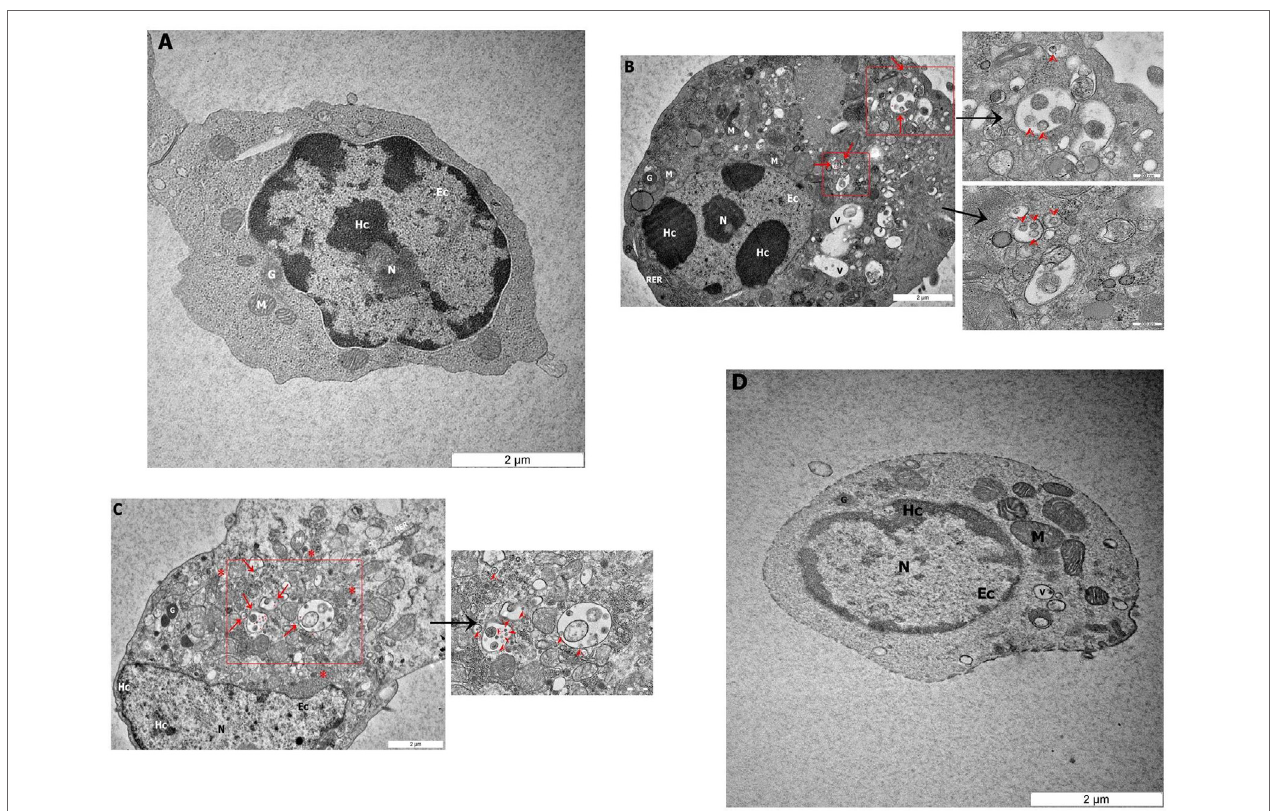
FigUre 2 | Transmission electron microscopy micrograph of CD3 − /28-4 + enriched IEL-NK cells from duodenal loop of uninfected and infected chickens. The picture demonstrated (a) the uninfected (control) natural killer cells (NK) with normal structures. The NK cell isolated from duodenum infected with velogenic groups, AF2240-I (B) , IBS005/11 (c) and lentogenic group, LaSota (D) . (B,c) Variable amounts of viral particles are taken up into vesicular structures (red arrow). The smaller boxes show the higher resolution of the viral particles. (D) The picture demonstrated the LaSota NK cell with less moderate mitochondria and the chromatin was lower condensed compared to control. Organelle marks: mitochondria (M), granule (G), rough endoplasmic reticulum (RER), nucleus (N), heterochromatin (Hc), euchromatin (Ec), vesicular structures (red arrow), viral particles (red arrowhead), vacuole (V), ribosomal aggregation (red